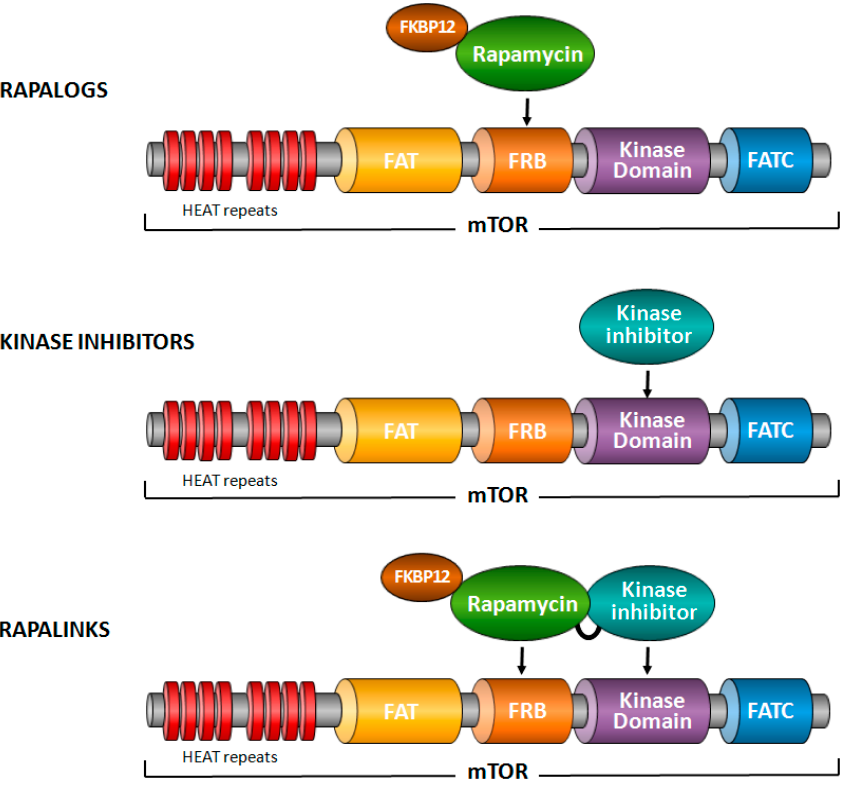
Figure 1. mTOR inhibitors. Three different types of mTOR inhibitors have been developed. Rapalogs, such as rapamycin, bind together with FKBP12 to the FRB domain of mTOR and block some functions of mTORC1. Kinase inhibitors of mTOR bind to the kinase domain of mTOR and block both mTORC1 and mTORC2. Rapalinks are composed of rapamycin cross-linked to a kinase inhibitor of mTOR. In 1981, the anti-cancer activity of rapamycin was reported in various cancer cell lines [15]. Since